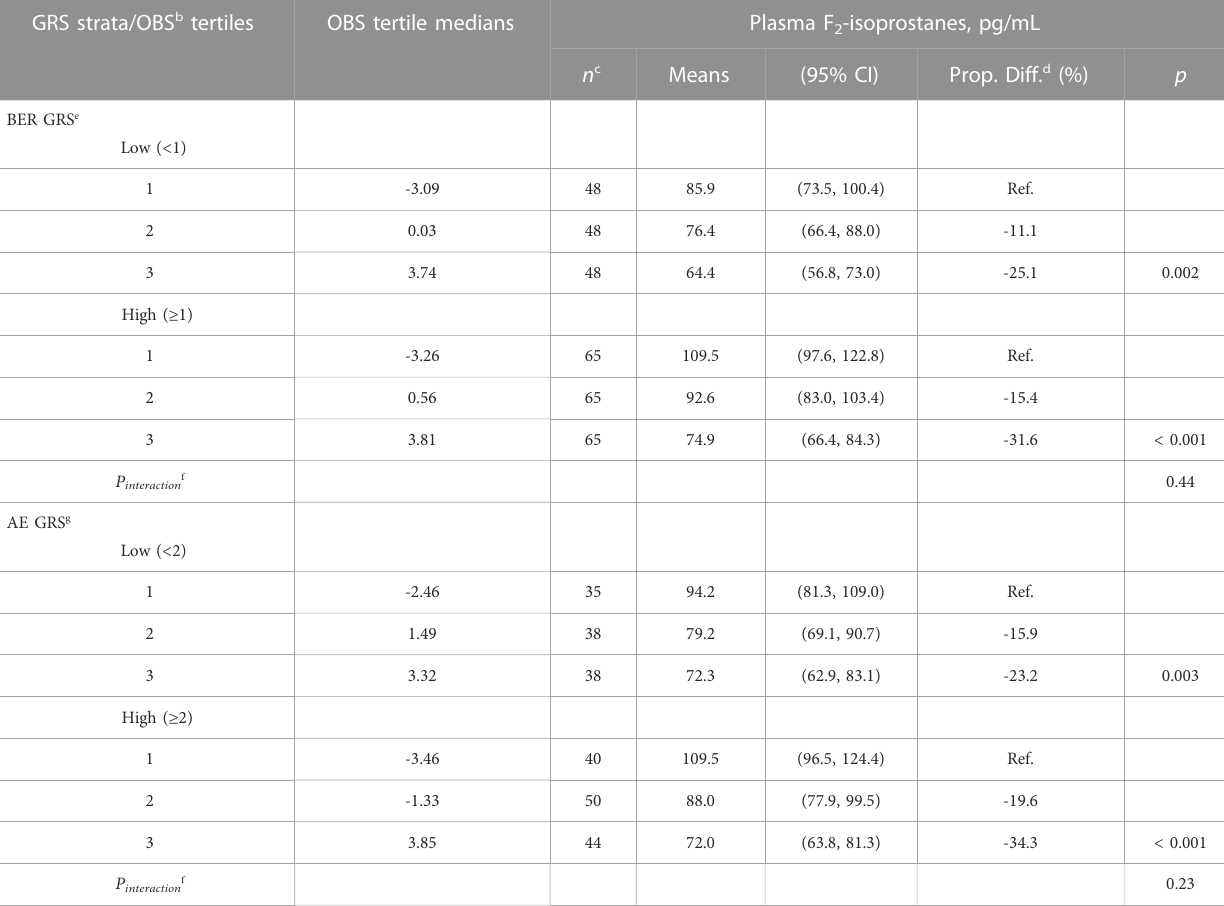
TABLE3Mean a plasmaF 2 -isoprostanesconcentrationsacrosstertilesofanoxidativebalancescore(OBS),strati fi edbydichotomizedBERandAEgeneticriskscores (GRS), in the pooled MAP I and MAP II cross-sectional studies. GRS strata/OBS b